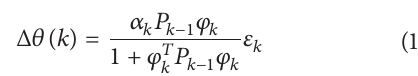
algorithm with an adaptive updating rule based on